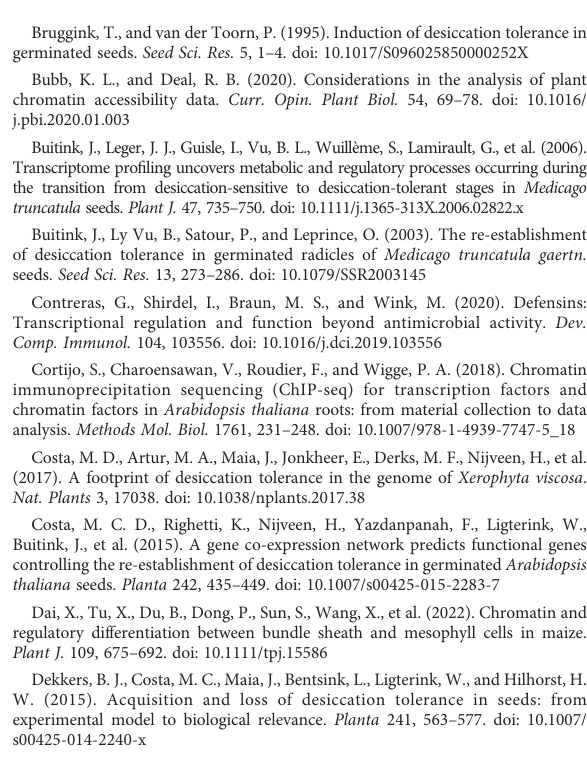
SUPPLEMENTARY FIGURE 2 Genes in open chromatin regions in DS samples. (A) GO enrichment analysis of genes in DS-DARs. Signi fi cantGO terms (FDR< 0.05, minimum number of mapped gene > 2) in “ biological process ” were represented. Fold change represents fold enrichment of genes with the given term as compared to the whole gene set annotated in Medicago. (B) Venn diagrams show overlaps between genes in DS-DARs detected by ATAC- Seqandgenesbelongingtocluster5detectedbyRNA-Seq.No signi fi cant overlap was detected ( P values from Fisher ’ s exact test; OR: odds ratio which represents the strengthof association, with OR>1 corresponding to a strong